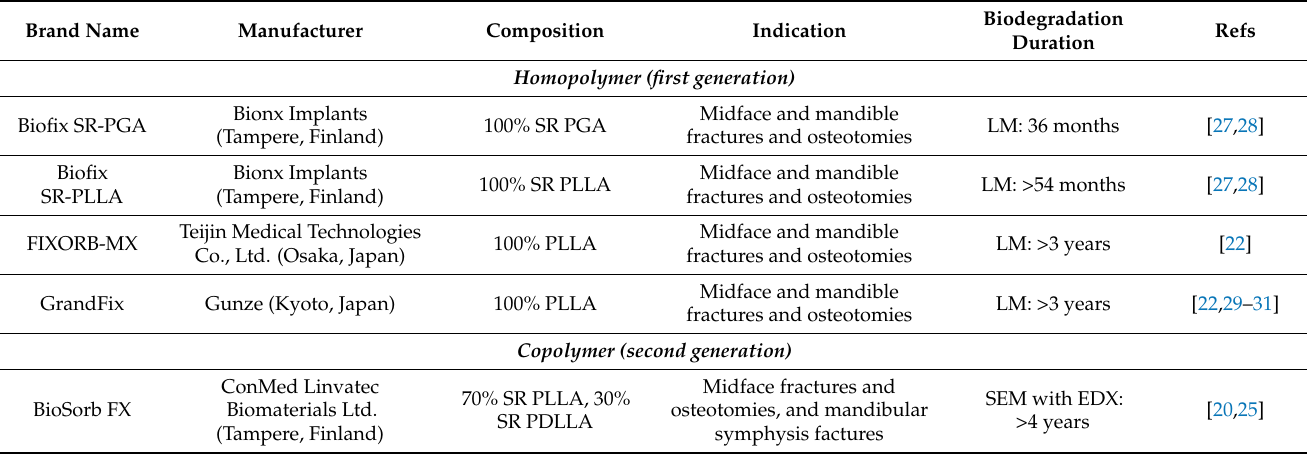
Table 1. Commercially available biodegradable osteosynthesis systems for maxillofacial